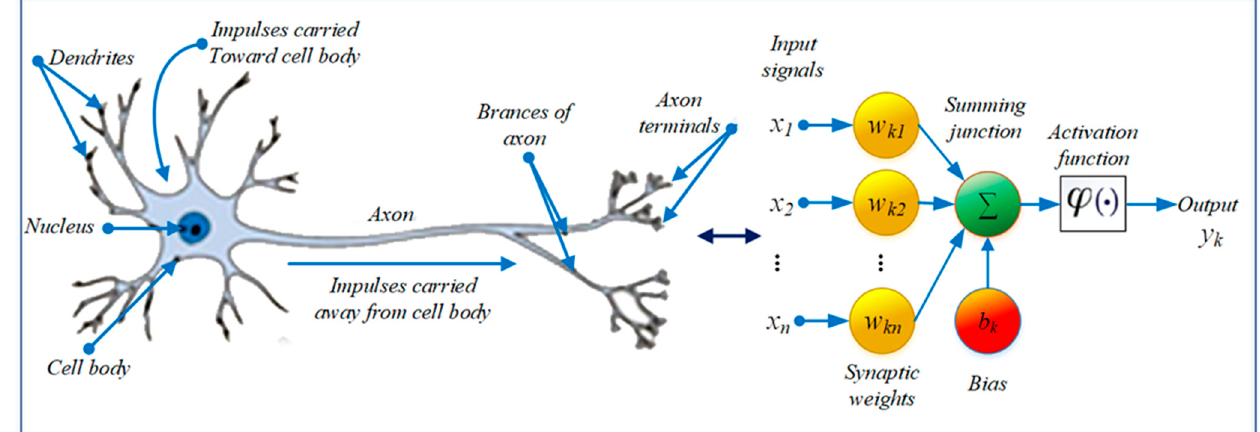
Figure 9. Neural network concepts.